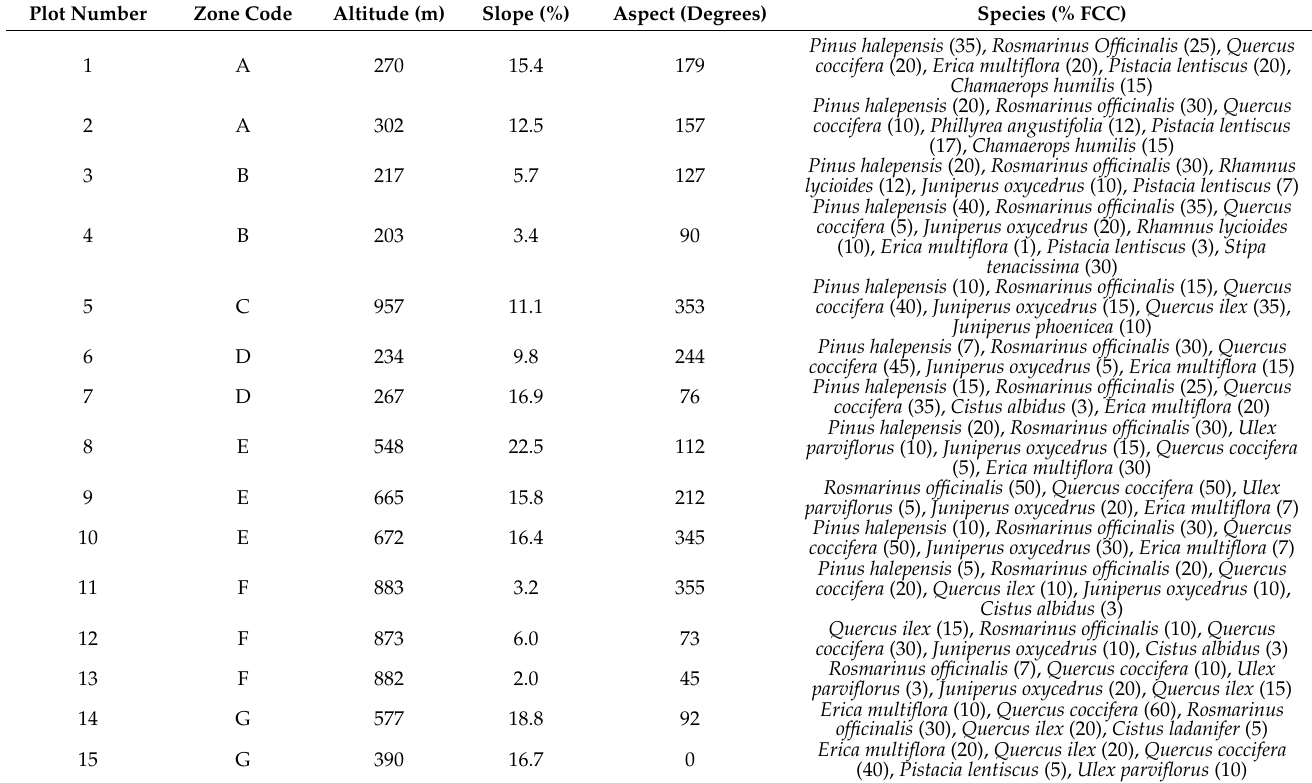
Table 1. Description of the calibration plots. The attributes are the following: plot number and zone code (see Figure 1), altitude and slope (in center of the plot), aspect (degrees), the names of the most representative species per plot, and their specific